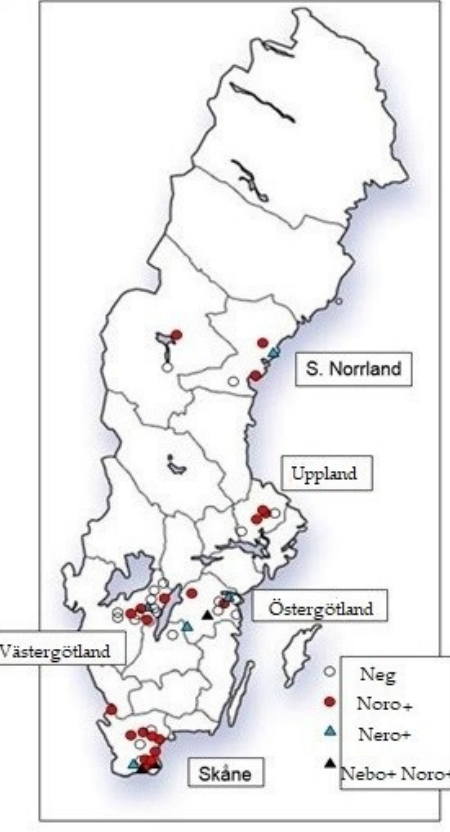
Figure 1. Geographic location of dairy herds positive or negative for bovine norovirus (Noro) and nebovirus